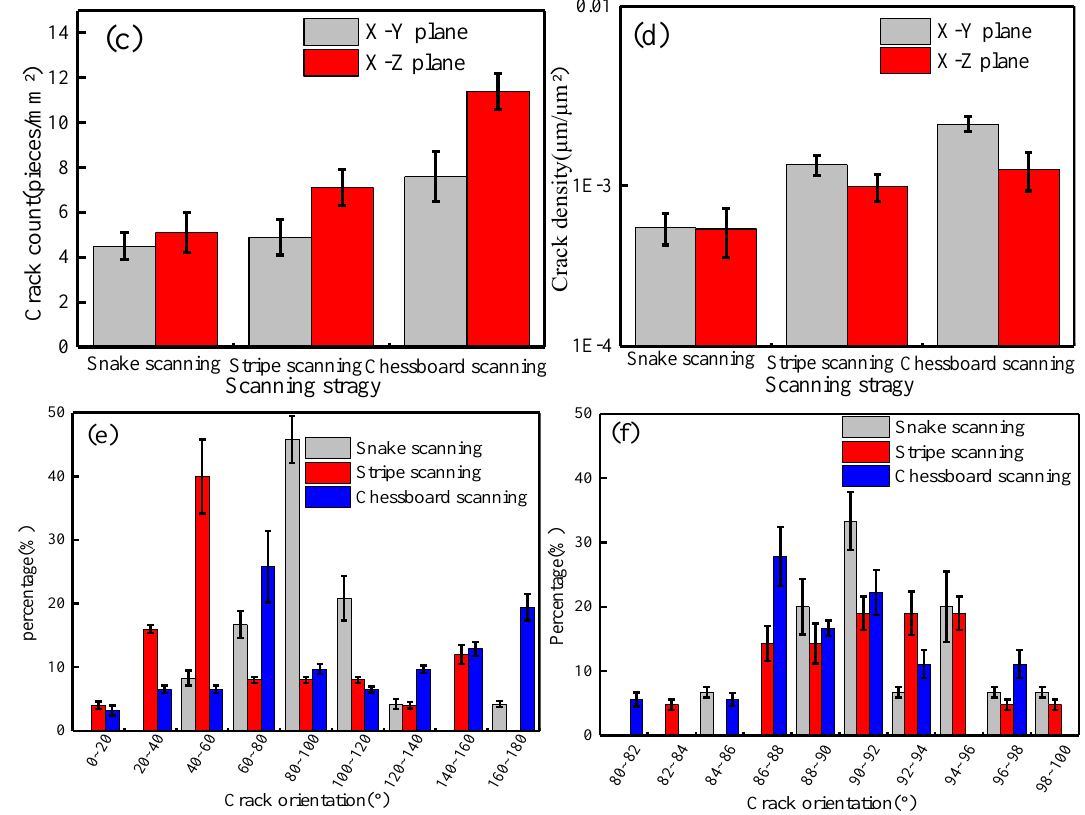
Figure 5. Statistical analysis of cracks in SLMed René104 superalloy samples; ( a ) crack length in the X–Y plane; ( b ) crack length in the X–Z plane; ( c ) crack number; ( d ) crack density; ( e ) crack orientation in the X–Y plane; and ( f ) crack orientation in the X–Z plane.